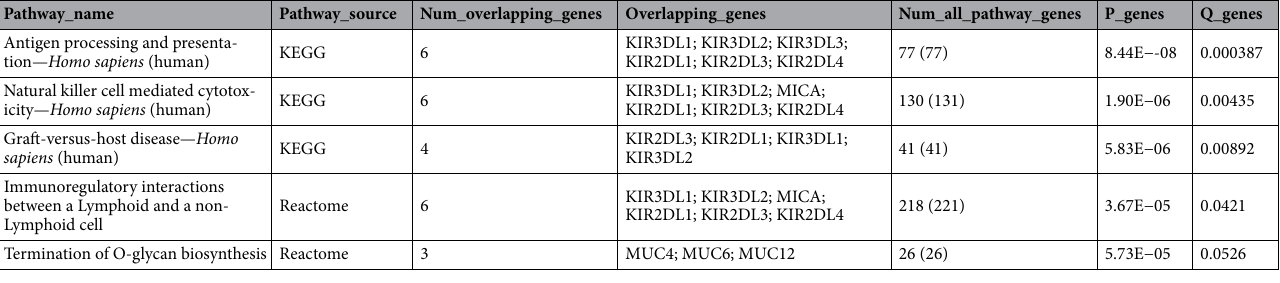
Table 1. IMPaLa pathways enrichment analysis results for the list of 74 multiSNP genes after removing HLA